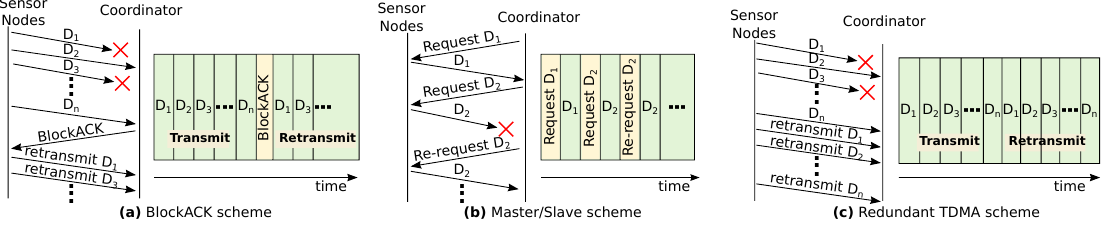
Figure 6. Slotted communication schemes used to increase network reliability. ( a ) BlockACK; ( b ) Master/Slave; ( c ) Redundant